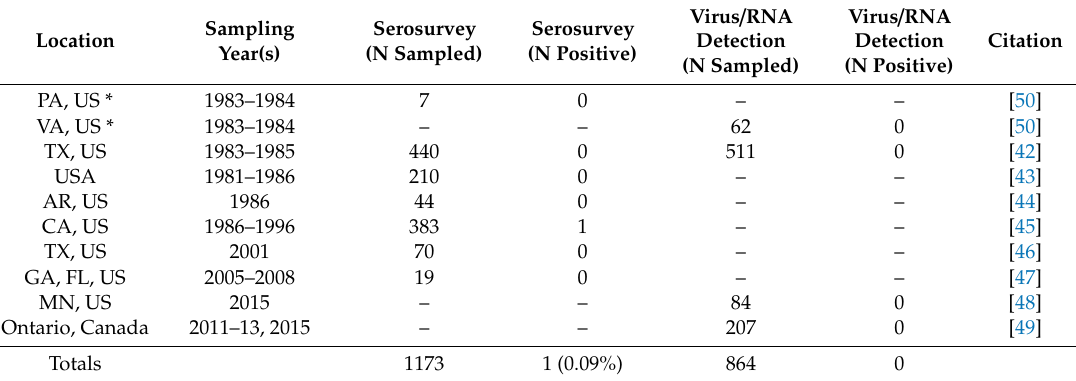
Table 1. Avian influenza A virus surveillance of wild turkeys in the US and